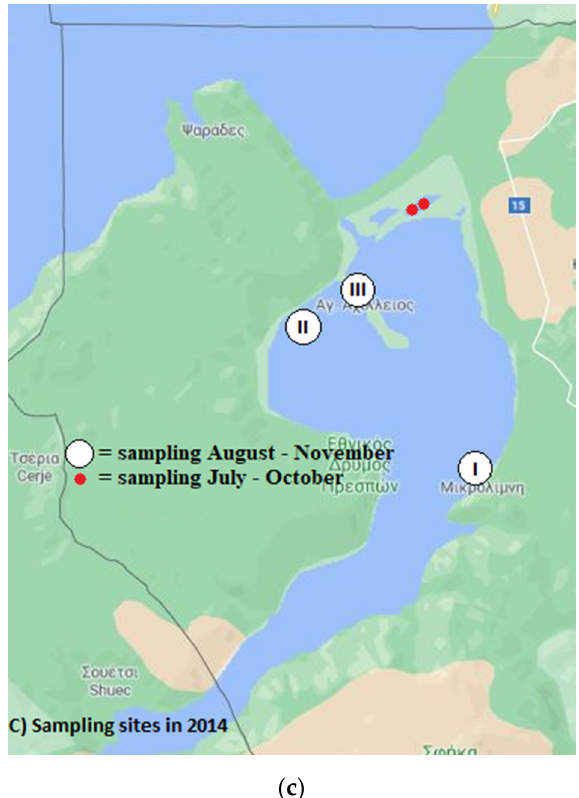
Figure 1. Sampling sites in Lake Great Prespa, Lake Lesser Prespa and pond Vromolimni in 2012 (Panel a ) and 2013 (Panel b ) and 2014 (Panel c ).